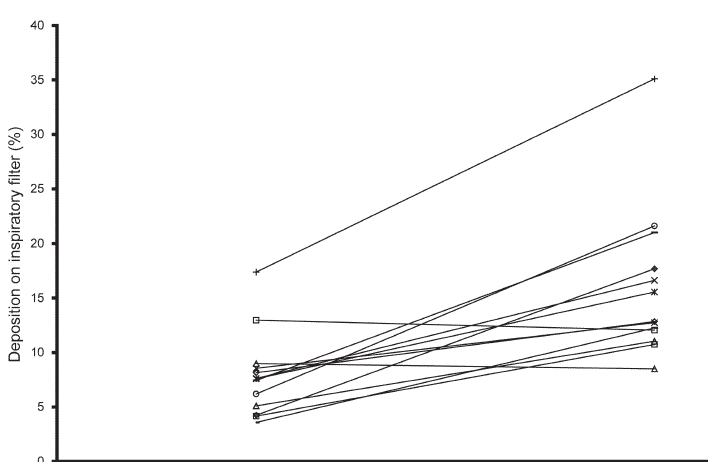
Drug deposited on the inspiratory filter expressed as a per- centage of the total dose when inhaling without and with a